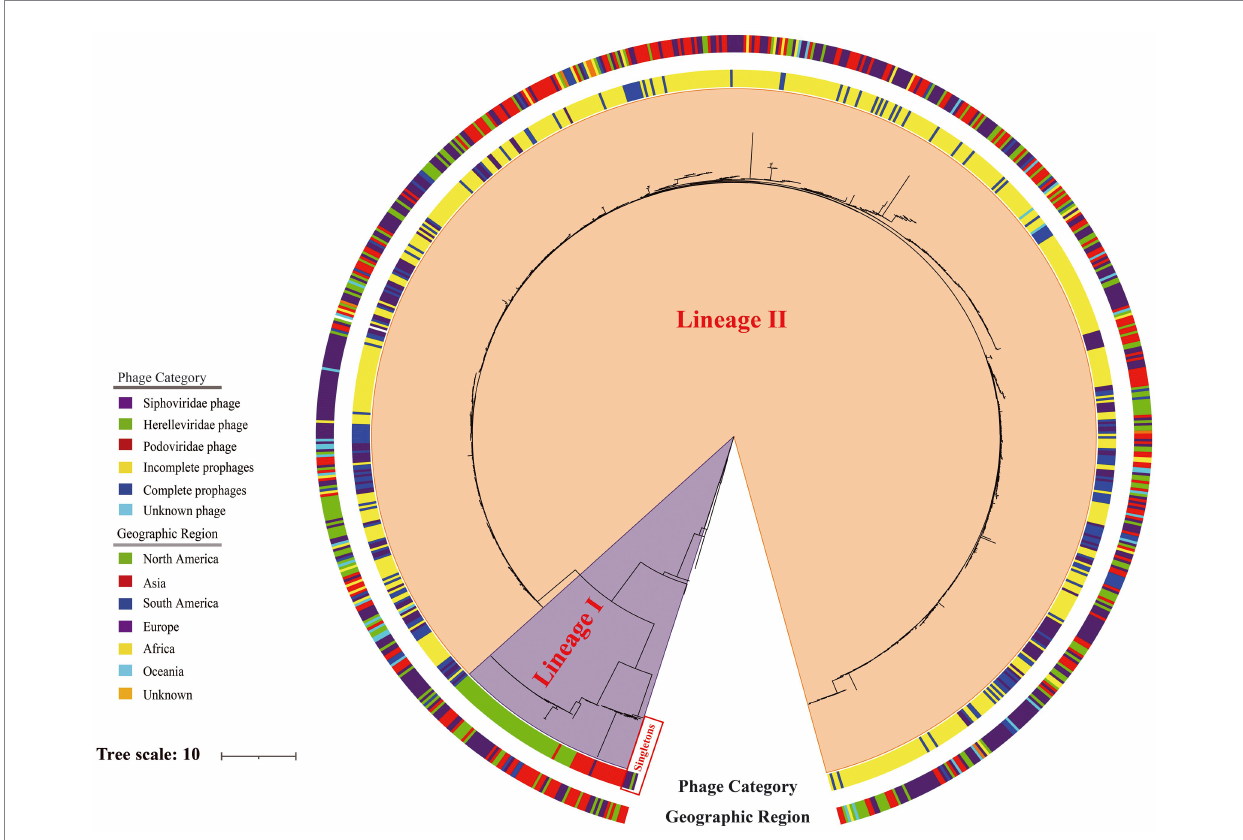
FIGURE 7 Phylogeny of 188 lytic phages, 148 representative intact prophages and 522 representative incomplete prophages analyzed using Erwinia phage phiEa2809 as the outgroup based on 439,973 single-nucleotide polymorphisms. The inner ring is colored according to type of the sequence and the outer ring according to the geographic